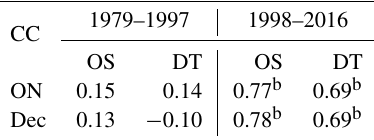
Table 1. The CC between the DHD CNC and SoilM index in October–November (ON) and December (Dec). OS means “origi- nal sequence” and “DT” means that the linear trend was